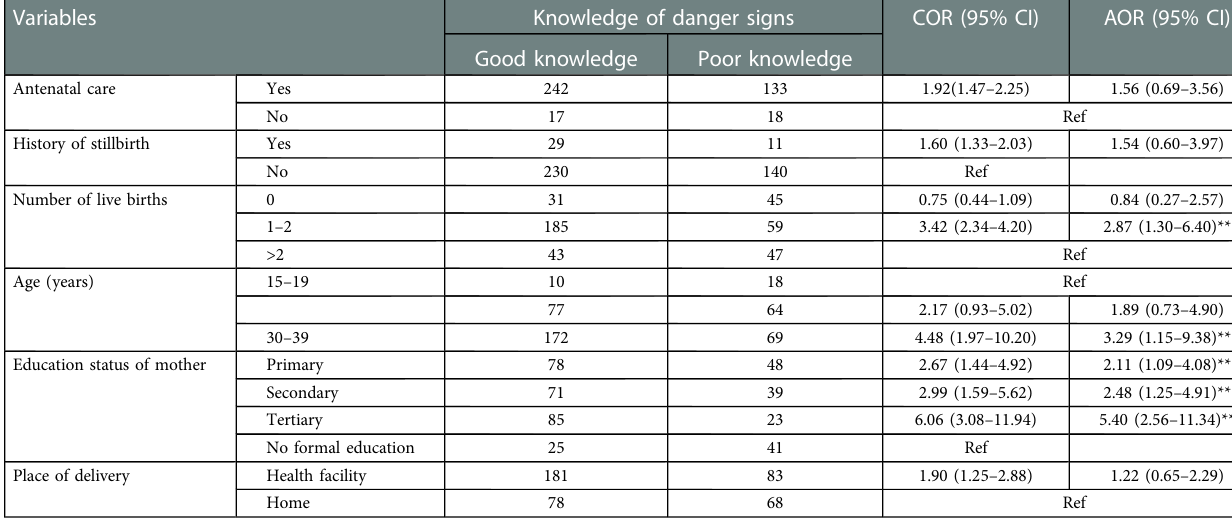
TABLE 4 Bivariate and multivariate analysis of factors associated with knowledge of obstetric danger signs among mothers in Hosanna Zuria Kebeles, Hadiya Zone, southern Ethiopia, 2021 ( N =410).